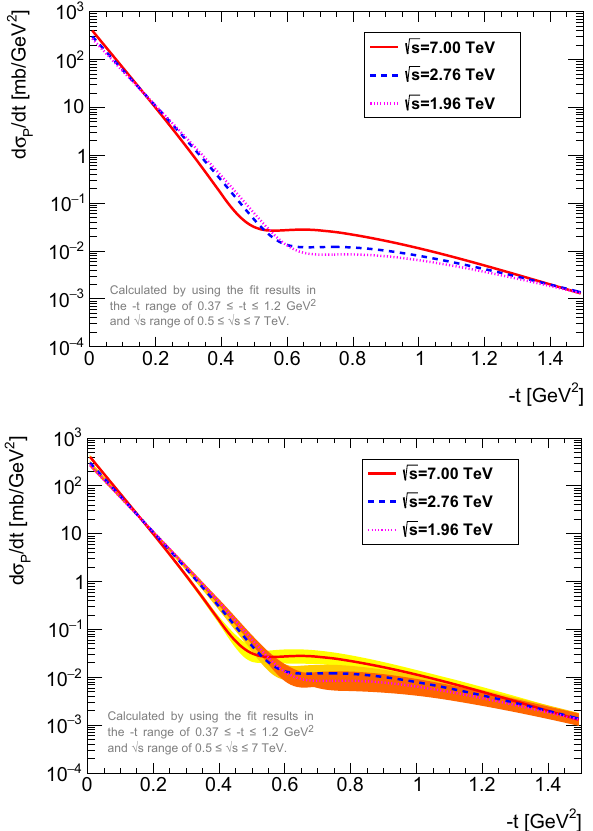
Fig. 22 Same as Fig. 21, but for the differential cross-section of the Odderon exchange Figure 21 indicates the calculated differential cross- section for Pomeron exchange based on the fits presented in the body of this manuscript, utilizing the ReBB model of Ref. [36]. This result is based on Table 2, that summarizes the parameters of the excitation functions for the opacity parameters α pp ( s ) , α p ¯ p ( s ) and the scale parameters, R q ( s ) , R d ( s ) , R qd ( s ) , corresponding to Fig. 6a–d in the body of this manuscript. The top panel indicates the central values for the differential cross-section of Pomeron exchange at various √ s , while the lower panel includes our colliding energies first estimates on the systematic errors of this reconstruction. These first error band estimates were obtained by neglecting the possibly strong correlations between the parameters p 0 and p 1 . These figures also indicate that Pomeron exchange does not lead to a pronounced diffractive minimum structure, in contrast to the experimental results for the diffractive mini- muminelastic pp collisions.Thisdifferentialcross-sectionis moresimilartotheneckandshouldertypeofstructure,exper- imentally observed in elastic p ¯ p collisions, as discussed in the body of this manuscript. Figure 22 is the same as Fig. 21, but for the C-odd Odderon exchange as evaluated from the ReBB model of Ref.